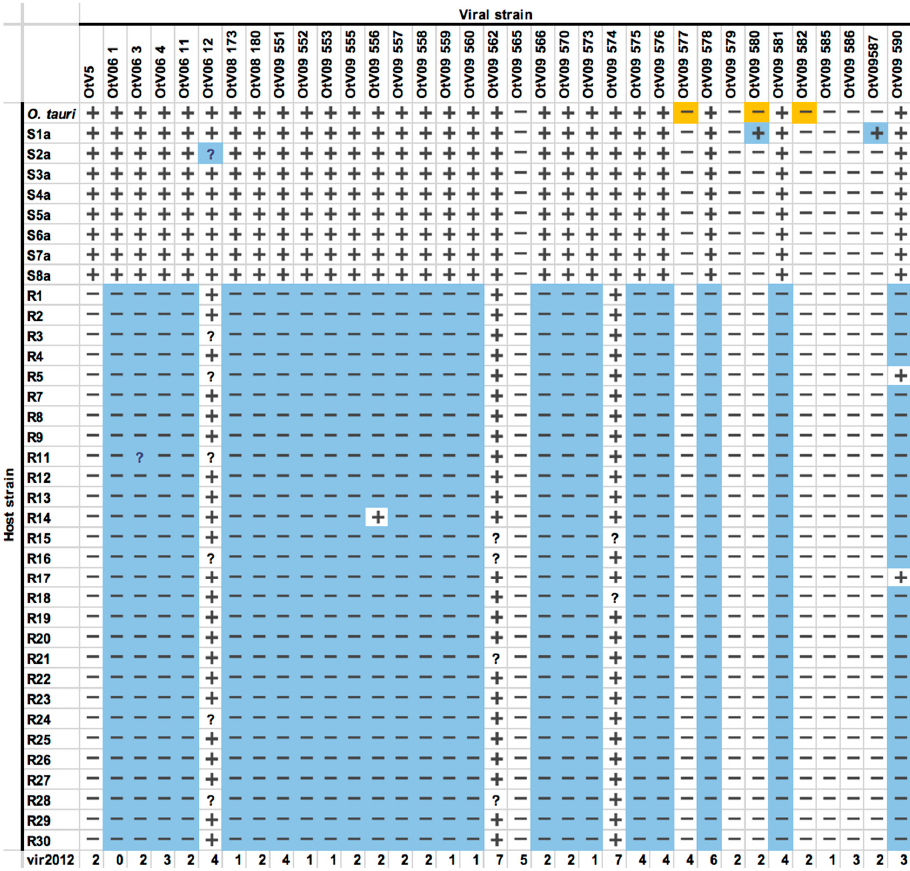
Figure 5. Altered spectrum of virus resistance in OtV5-resistant O. tauri lines. + : complete or almost complete host cell lysis - : no or little host cell lysis. ? : not possible to determine. Orange background cell: result on susceptible O. tauri control differed from previous observation [22]. Blue background cell: result that differed to the null hypothesis that the susceptibility of this strain would be the same as that previously observed (S1a to S8a controls and those of a past paper [22]). Note that OtV5 is not highlighted since these lines were selected for their resistance to this virus. S : susceptible clonal line [19]. R : resistant clonal line [19]. vir2012 : The number of independently isolated wild-type O. tauri strains on which the viral isolate shown was noted as virulent out of 12 tested previously [22] (excluding the strain on which the virus was isolated).